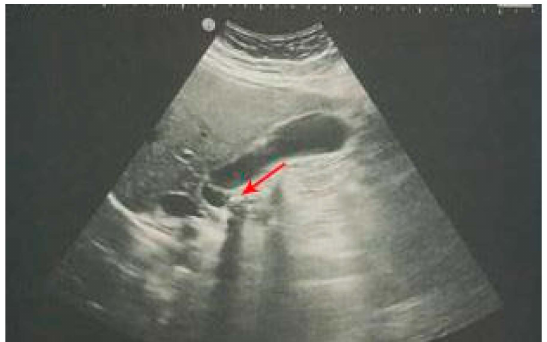
Figure 3. An impacted calculus in the neck of the gallbladder (red